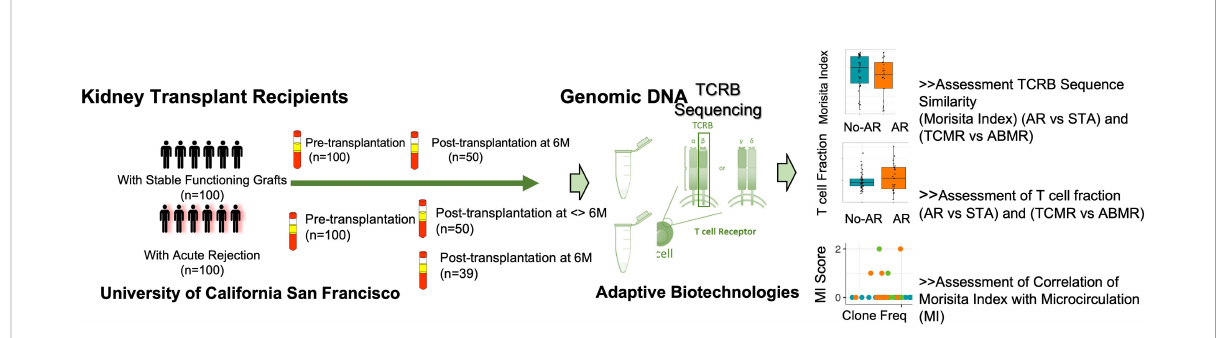
FIGURE 1 Study schematics. Validation of repertoire turnover and T cell fraction on post-transplant paired samples with and without acute rejection. Ninety-two AR samples and 98 STA transplant samples passed QC (>500 T cells) with suf fi cient T cell-derived DNA yield for